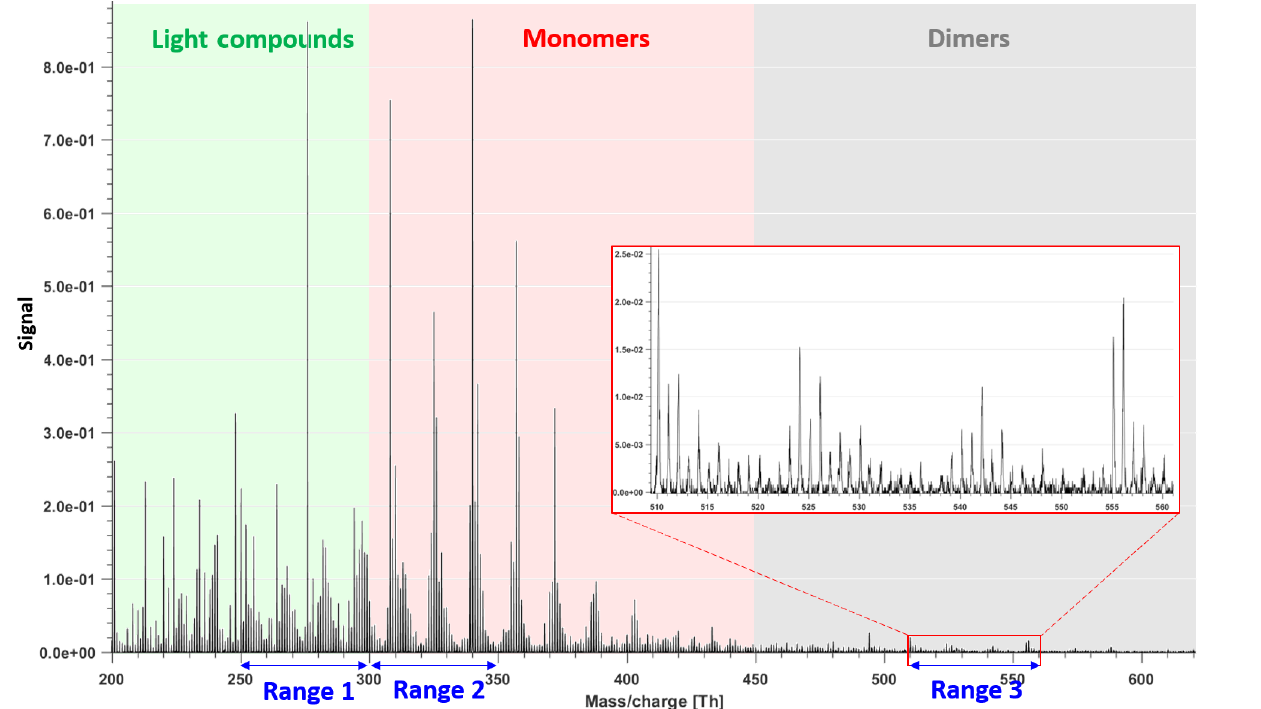
Figure 1. Example of mass spectrum with 1h time resolution measured from a boreal forest environment during the IBAIRN campaign (at 18:00LT, Finnish local time, UTC + 2). The mass spectrum was divided into three parts, and three subranges were chosen from different parts for further analysis in our study. The nitrate ion (62Th) is included in the